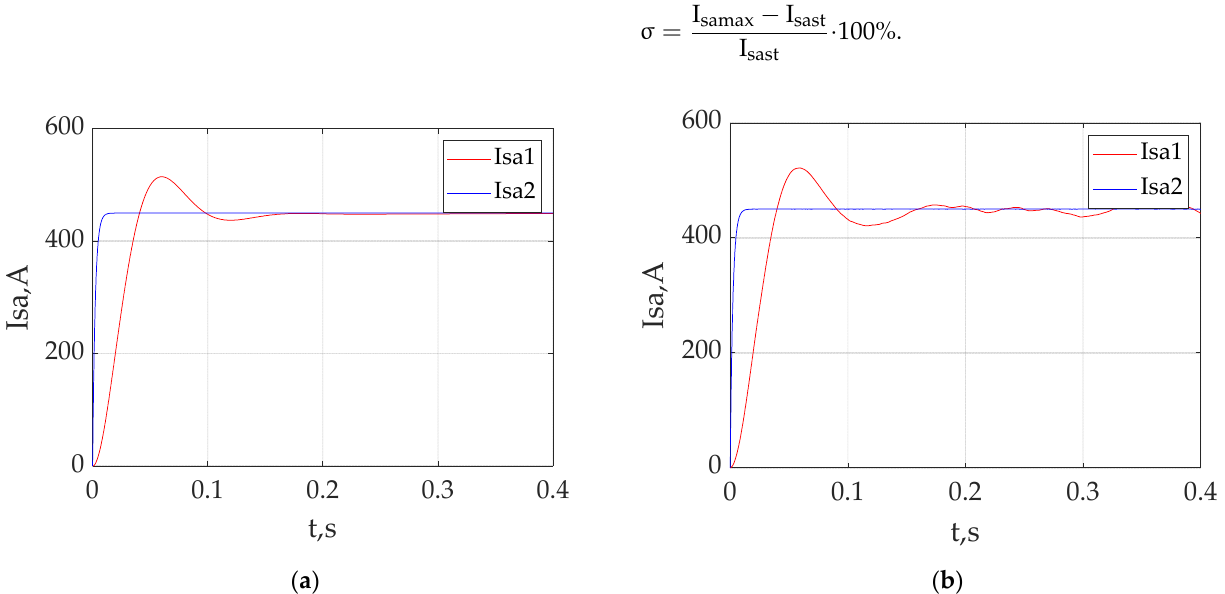
Table 3. The results of comparison of the control quality of the basic system versus the system with optimal controller.